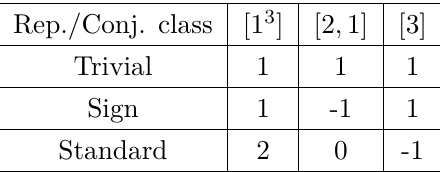
Table 2 . The character table for the group S 3